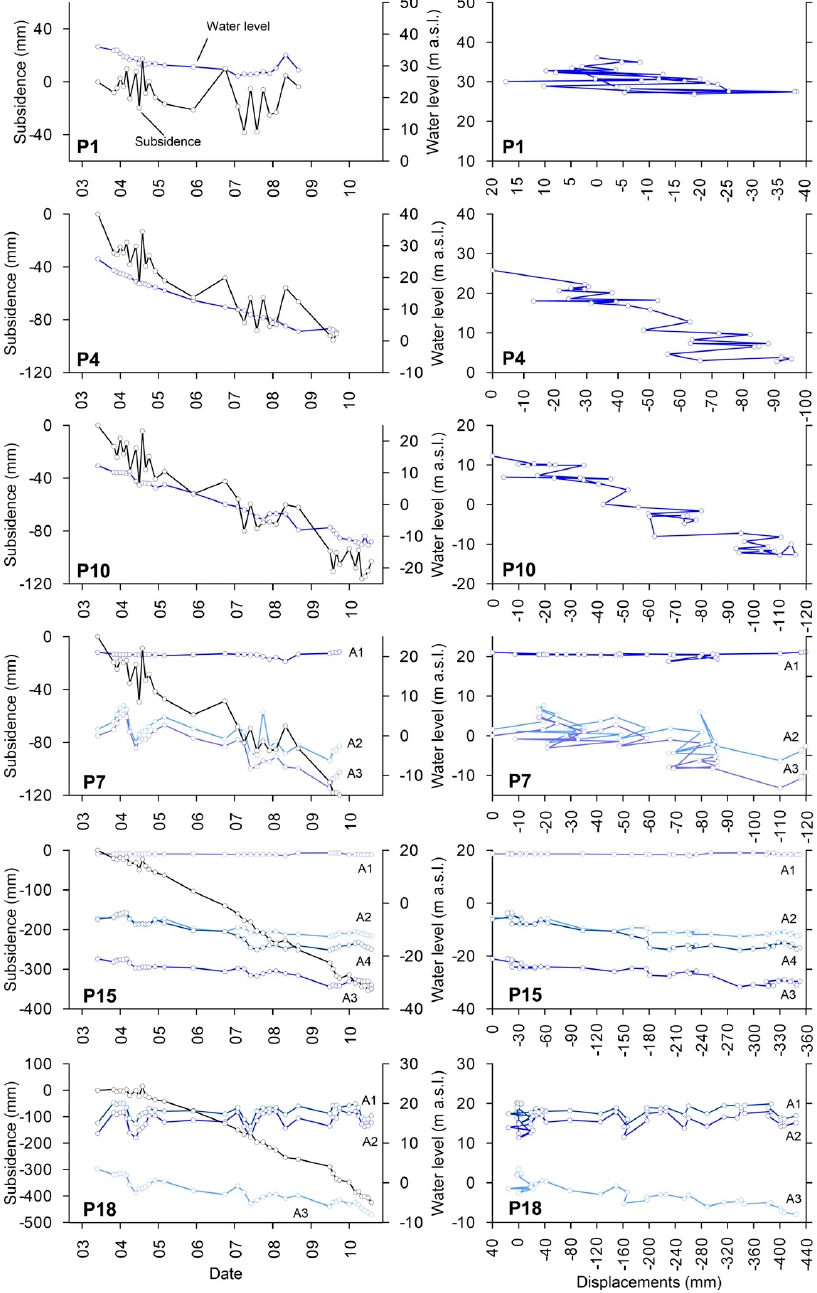
Figure 9. Time series of piezometric level and land subsidence measured by means of InSAR ( left ); and strain-stress curves, for different areas of Beijing ( right ). The location of the observation wells is shown in Figure 3. Note that the wells are ordered from north ( top ) to south ( bottom ). A1 to A4 refers to different aquifers units described in Section 2.